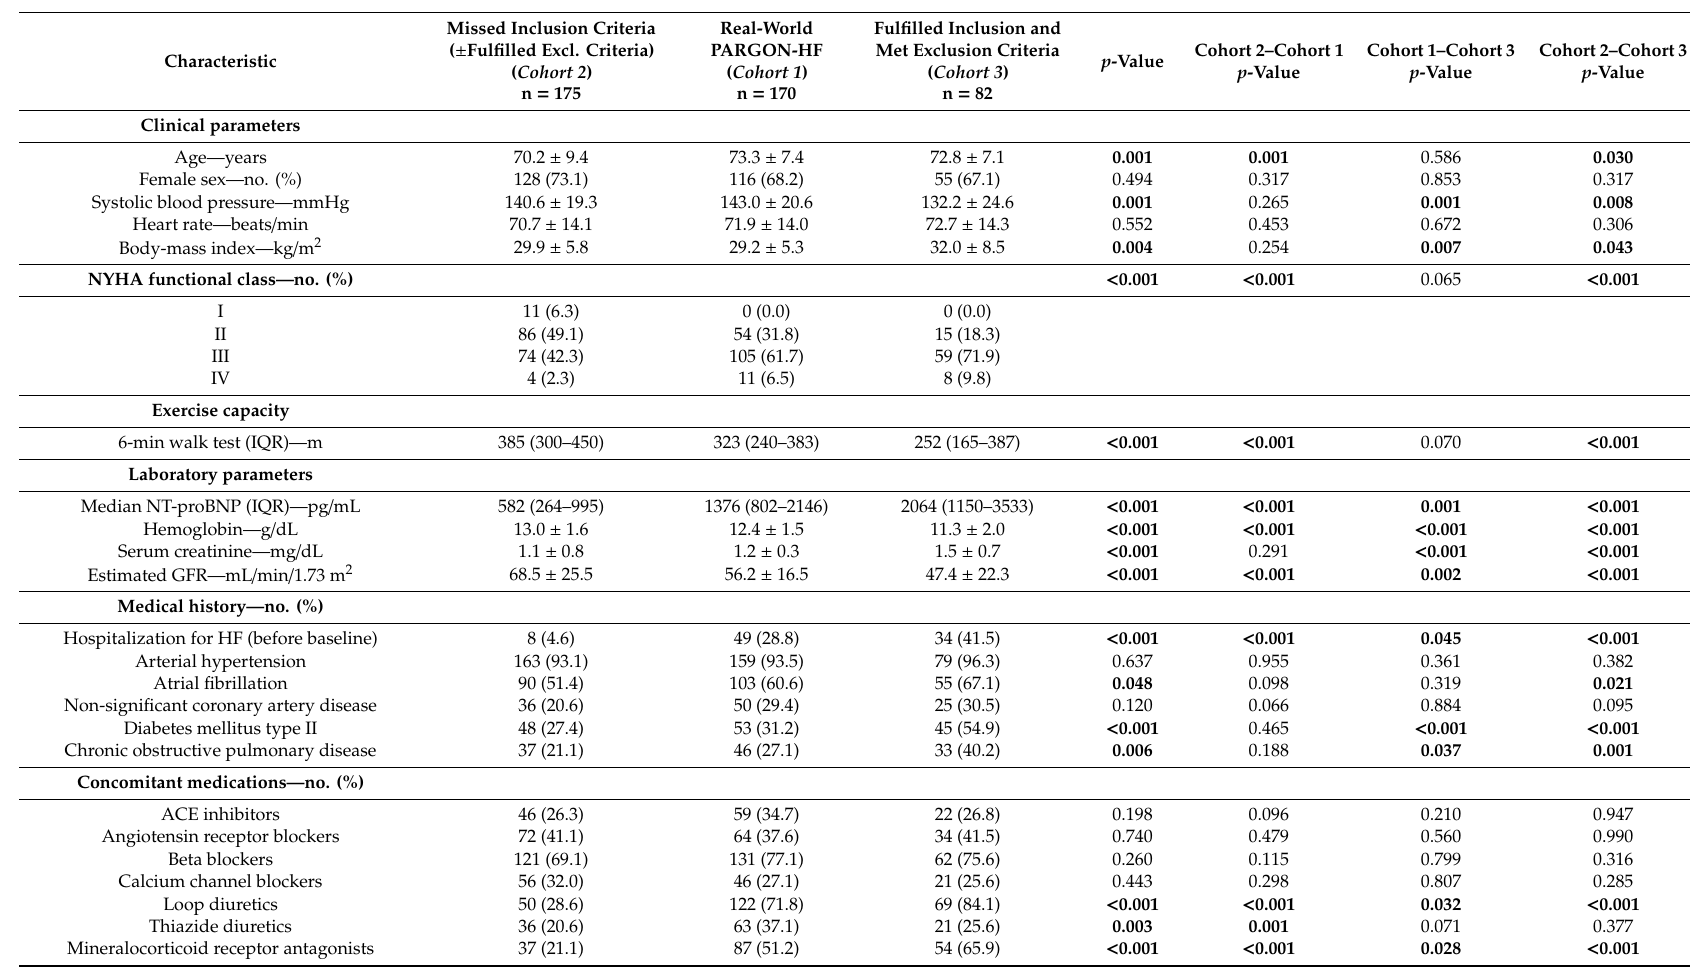
Table 3. Baseline characteristics of the real-world HFpEF cohort according to eligibility for